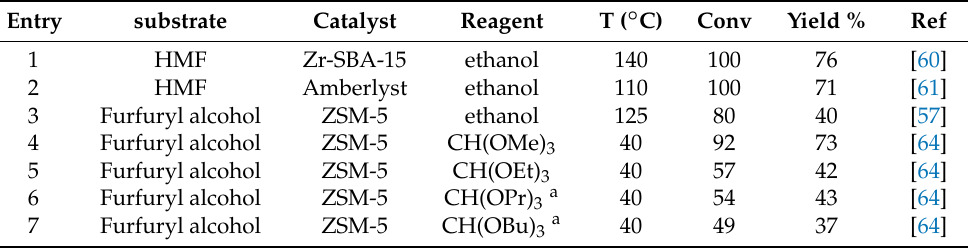
Table 3. Comparison of catalytic procedures for furanic ethers by direct